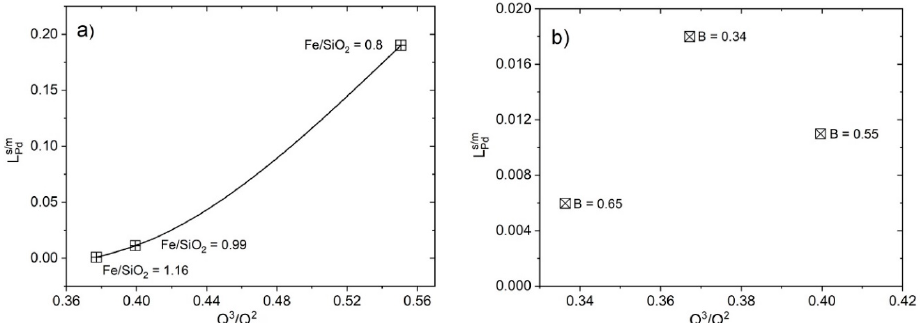
Figure 14. Relationship of the Q 3 /Q 2 and Pd partition- 𝐿 atm and T = 1300 ◦ C (1573 K) at di ff erent: ( a ) Fe / SiO 2 ratios and ( b ) levels of basicity.